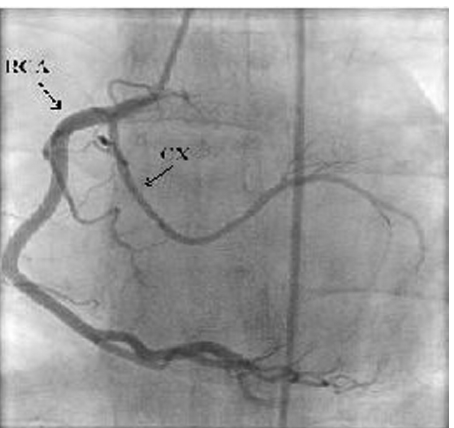
Figure 2 - Coronary angiography from the left lateral view, not showing the circumflex artery. Figure 3 - Anomalous circumflex arising from the right coronary